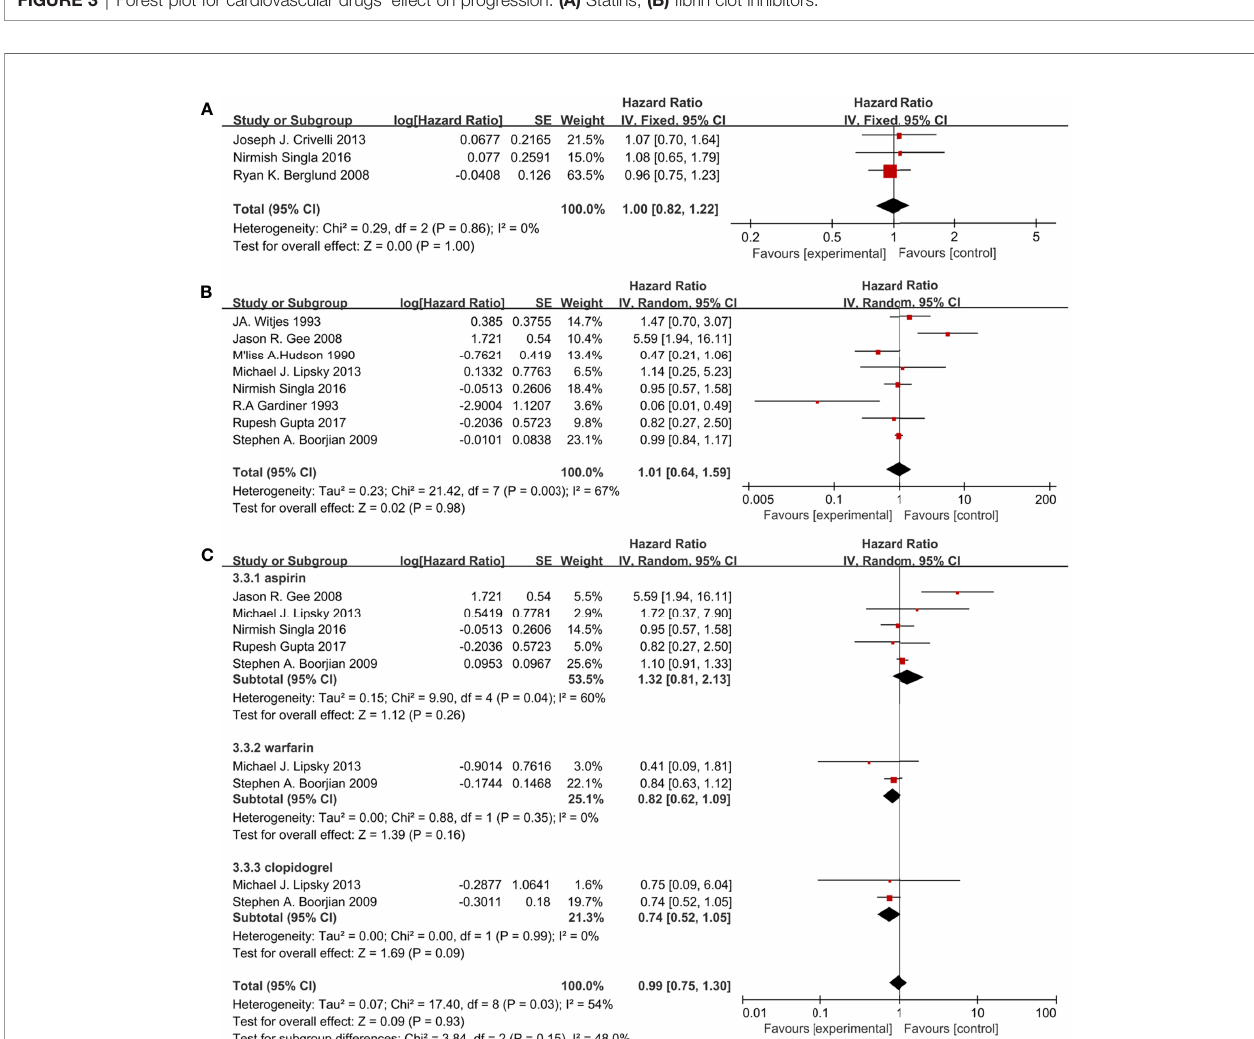
FIGURE 3 | Forest plot for cardiovascular drugs ’ effect on progression: (A) Statins, (B) fi brin clot inhibitors.